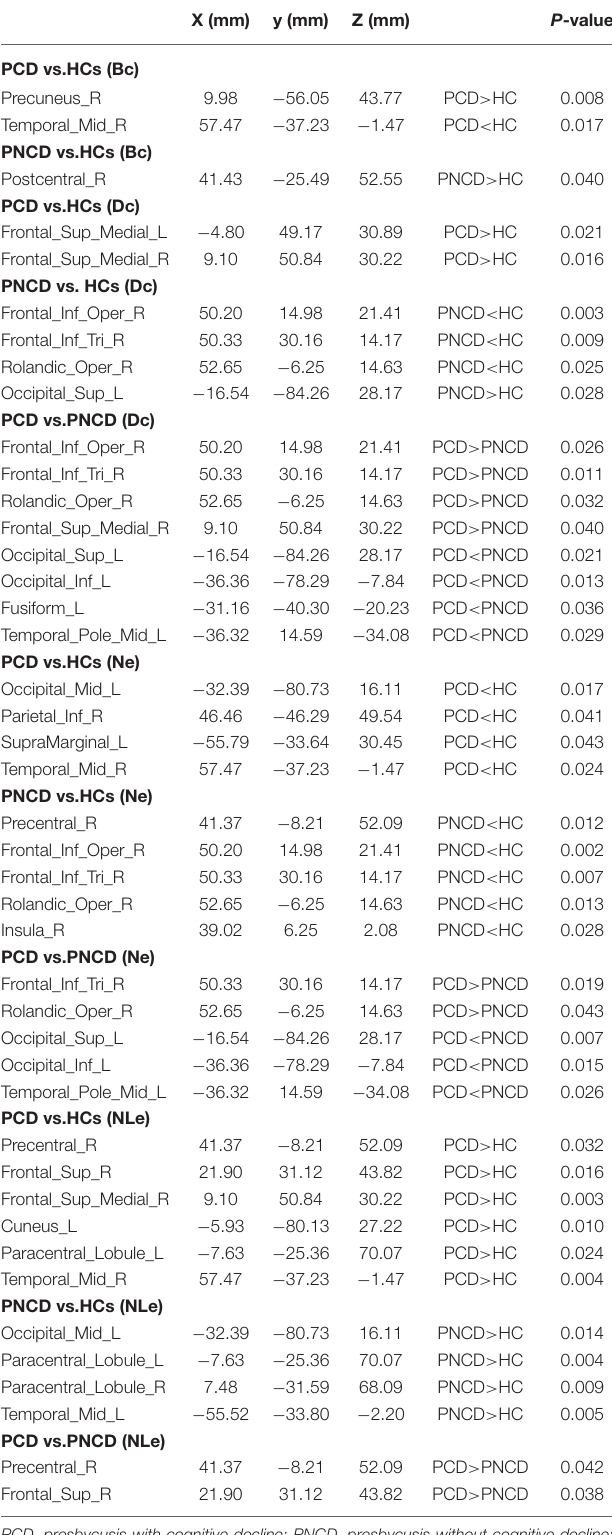
TABLE 2 | Nodes with significant grouping differences in nodal